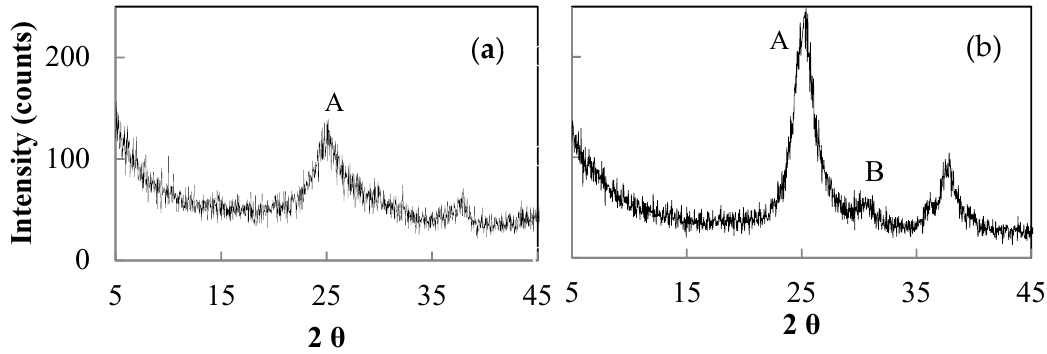
Figure 16. XRD patterns of sample hydrolysed at r.t. for 1 h with 1.0 M NH 4 OH, peptized for 1h with 0.1 M HNO 3 , dried by lyophilization ( a ) or at 60 °C ( b ) and calcined for 2 h at 450 °C with a ramp rate of 30 °C/min ( b , d ). (A = anatase; B = brookite).